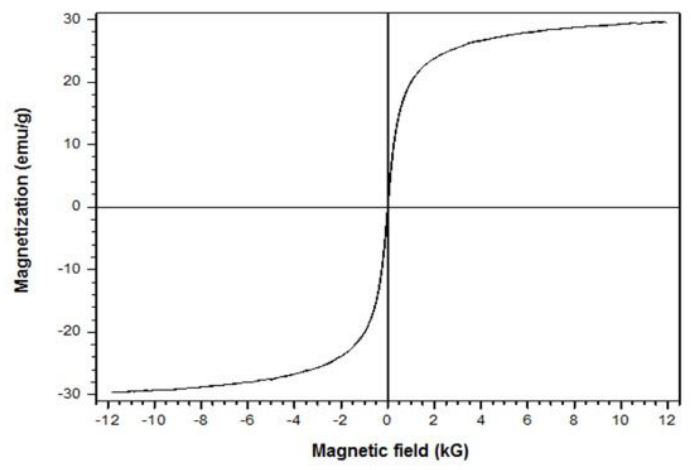
Figure 4. Variation of magnetization with the applied field of microspheres based on gelatin, fructose and magnetite obtained by ferrous sulfate